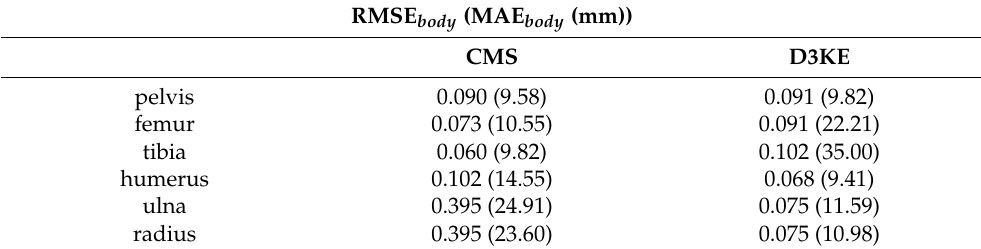
Table 2. Errors in scaling factors of the proposed method and the baseline compared against the ground truth. D3KE shows better performance for the upper extremities and slightly worse perfor- mance for the lower